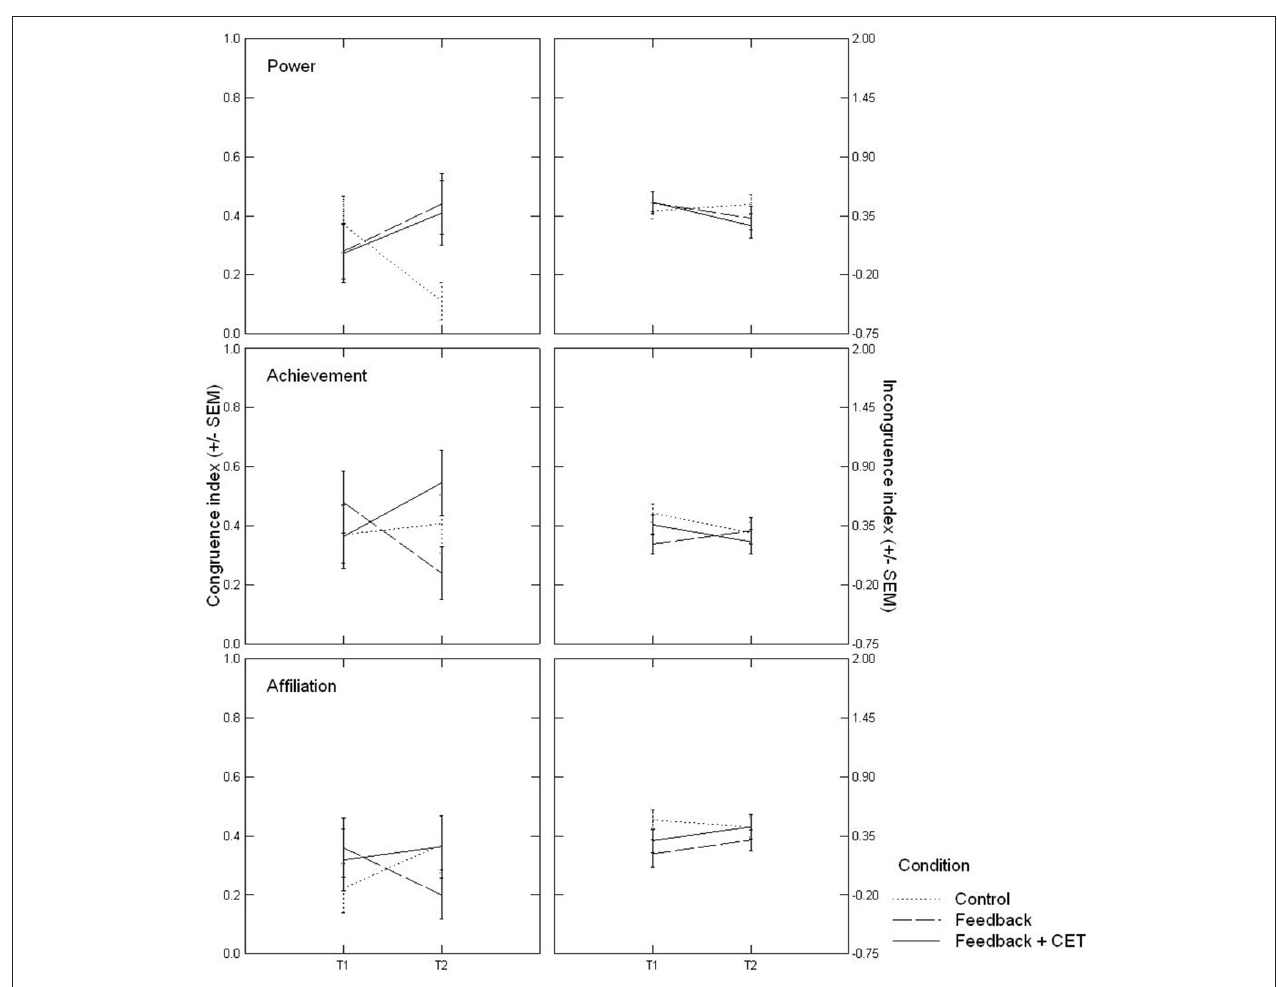
FIGURE 2 | Time × Condition effects, depicted separately by domain, on motivational congruence (Left) and motivational incongruence (Right) . CET, Congruence-enhancement training.